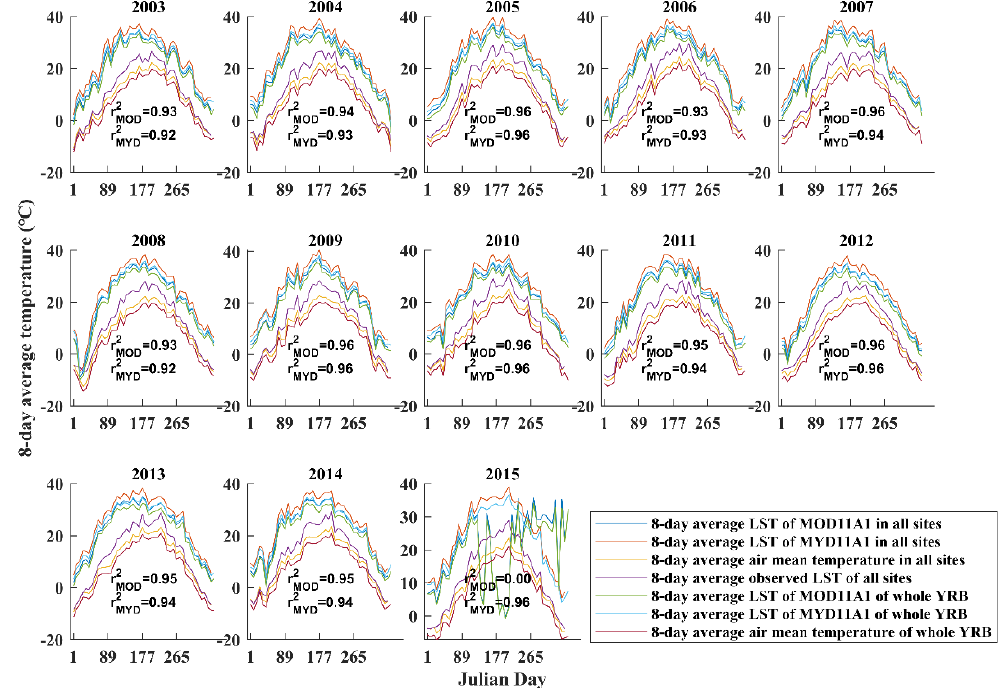
Figure 8. Evaluation of the 8-day average land surface temperatures for MODIS during the years 2003–2015. The text in the upper right corner of each figure indicates the coefficient of determination of the linear model between the 8-day average satellite LST and the 8-day average observed LST values. r 2 mod is the R 2 between sites LST and MOD11A2 LST. r 2 myd is the R 2 between sites LST and MYD11A2 LST.